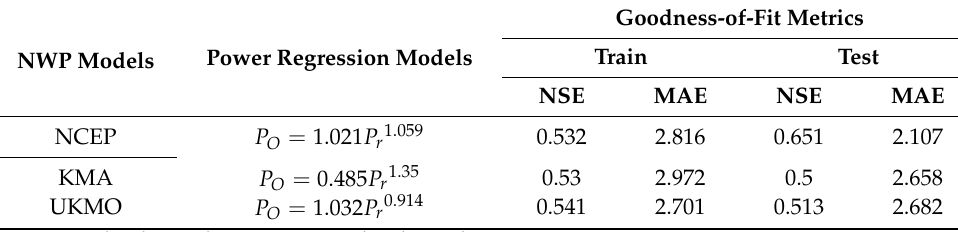
Table 8. Power regression models for post-processing the ensemble precipitation forecasts.